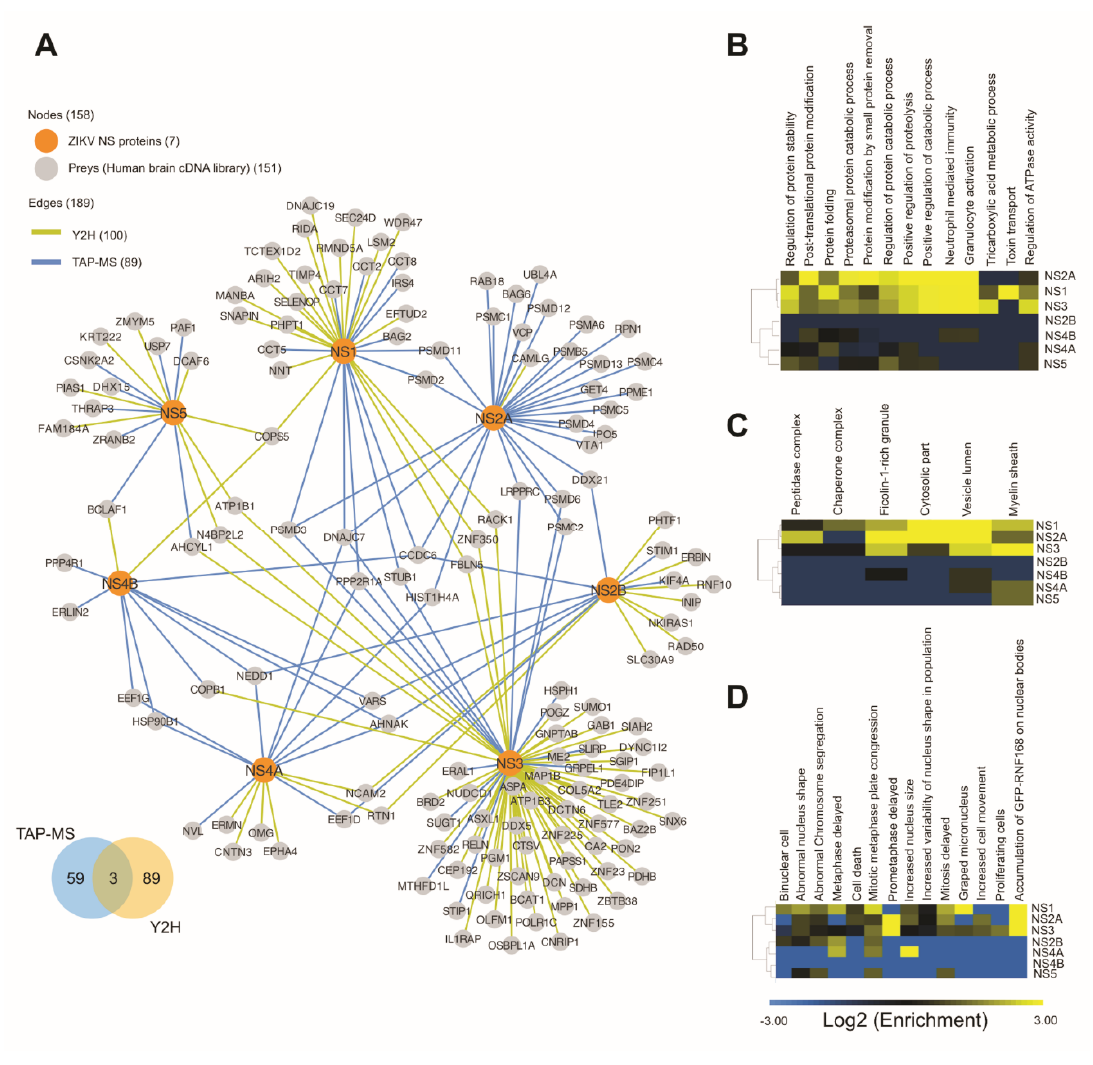
Figure 3. Merged ZIKV PIN. ( A ) Network of the interactions identified by Y2H and TAP-MS screens. The color legend is depicted on the upper left-hand corner. ( B , C ) Clustering of bait sets according to gene ontology (GO) enrichment ratio for biological processes ( B ) and cellular component ( C ). ( D ) Phenoclusters (clustering of bait sets according to enrichment or depletion of Mitocheck phenotype classes. Clustering and visualization were performed using Cluster v3.0 software and TreeView v1.1.6r4, respectively.